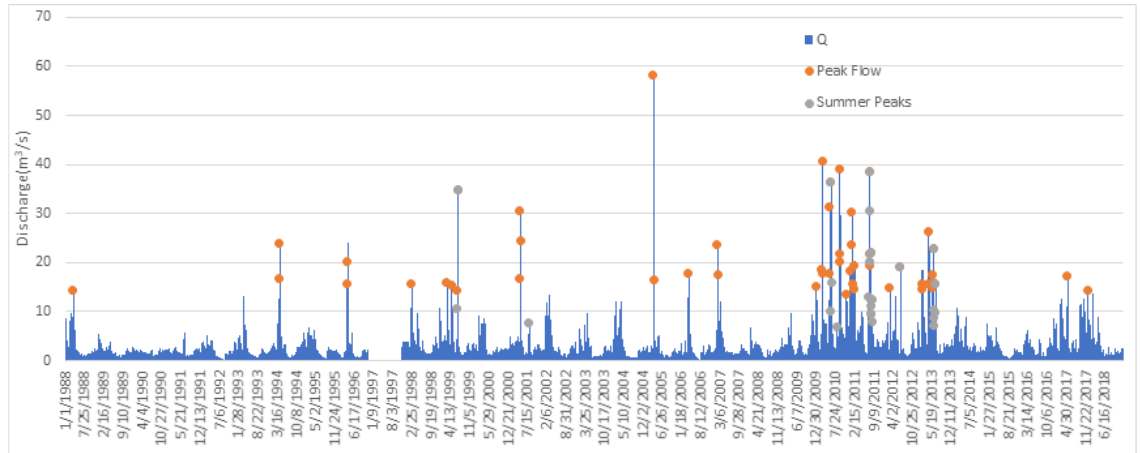
Figure 5. Time series of daily discharge at the IMGW-PIB flow gauge Piaseczno 2 from 1988 to 2018, with the selected peaks highlighted for the flood frequency analysis.